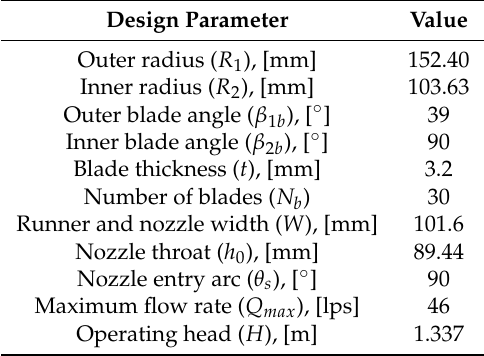
Figure 3. Schematic of the single-nozzle 0.53 kW turbine with η max = 88%. Note that the turbine does not have a guide vane. Table 1. Design parameters of the 0.53 kW turbine (88%